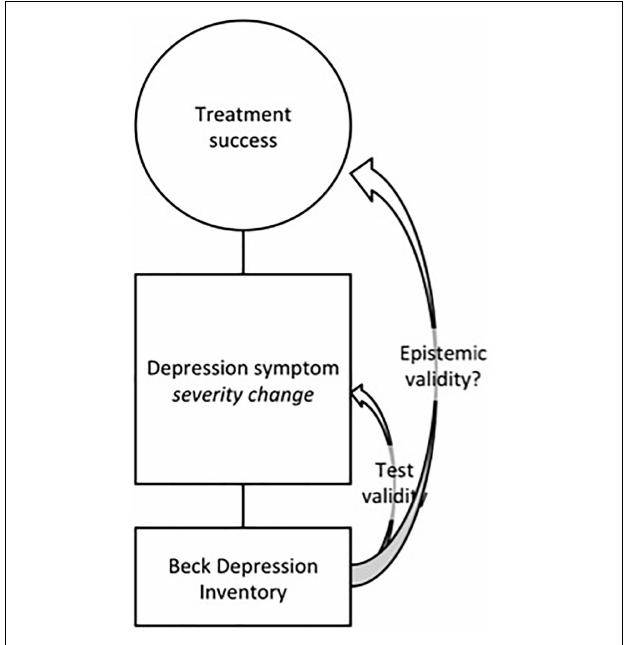
FIGURE 2 | Treatment success is operationalized as depression symptom severity change, which is operationalized as a difference score on the BDI (Beck et al.,